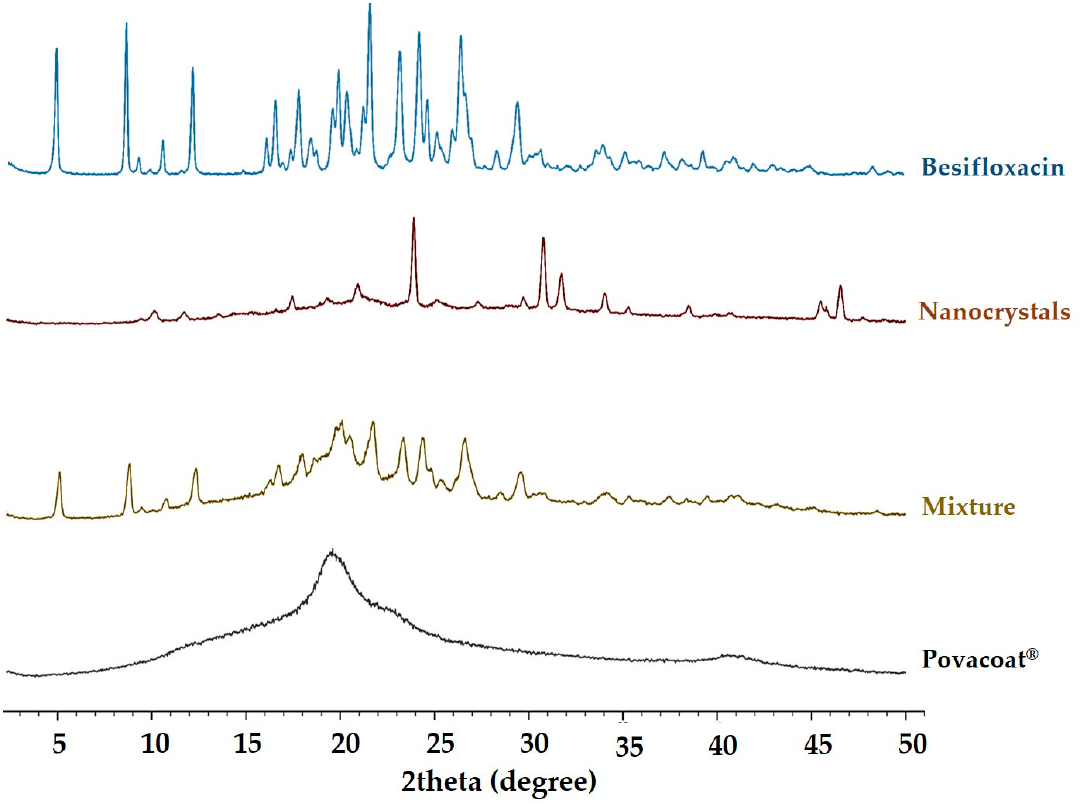
Figure 7. X-ray diffraction of besifloxacin (raw material), nanocrystals, mixture (besifloxacin and Povacoat ® ), and Povacoat ® . n = 3.